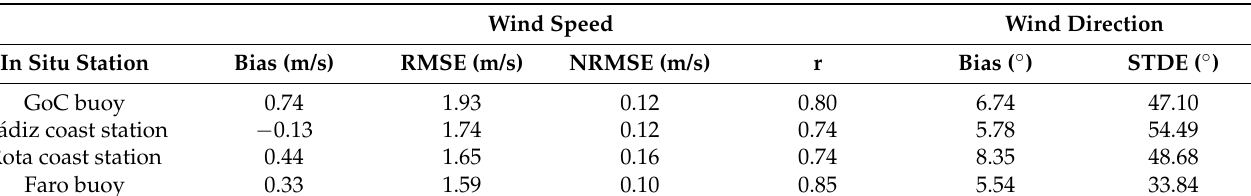
Table 3. Statistical scores from the comparison among in situ data from the different stations and buoys against simulations from the WRF model.